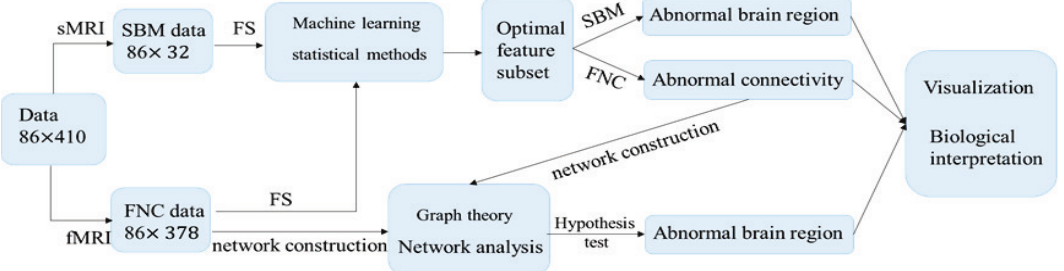
Figure 2. The flowchart of locating the abnormalities in brains for SZ. Where SBM refers to source-based morphometric, FNC refers to functional network connectivity and FS refers to feature